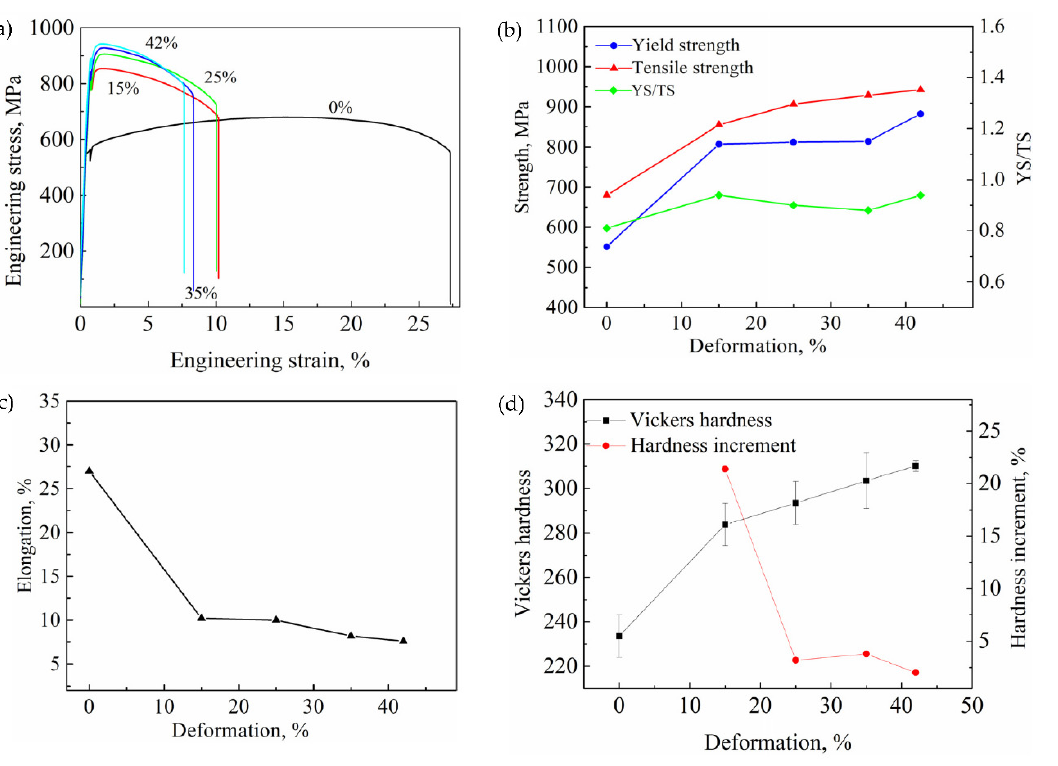
Figure 5. Mechanical property of Gr.4 strip for different cold-rolling deformations: ( a ) engineering stress–strain curves, ( b ) tensile strength and yield strength, ( c ) elongation, and ( d ) hardness curves.